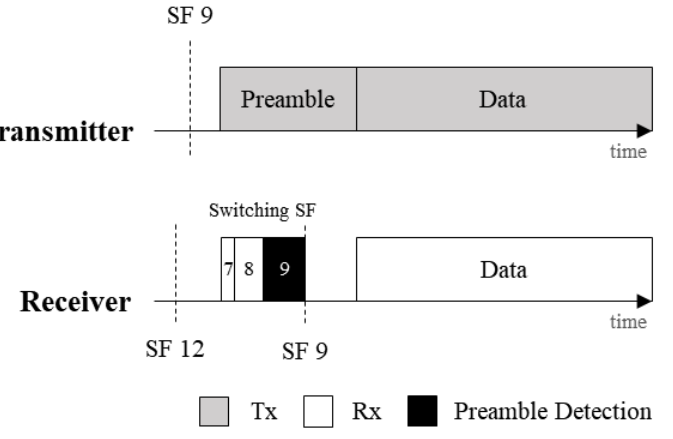
Figure 1. An example of the ASFS operation.